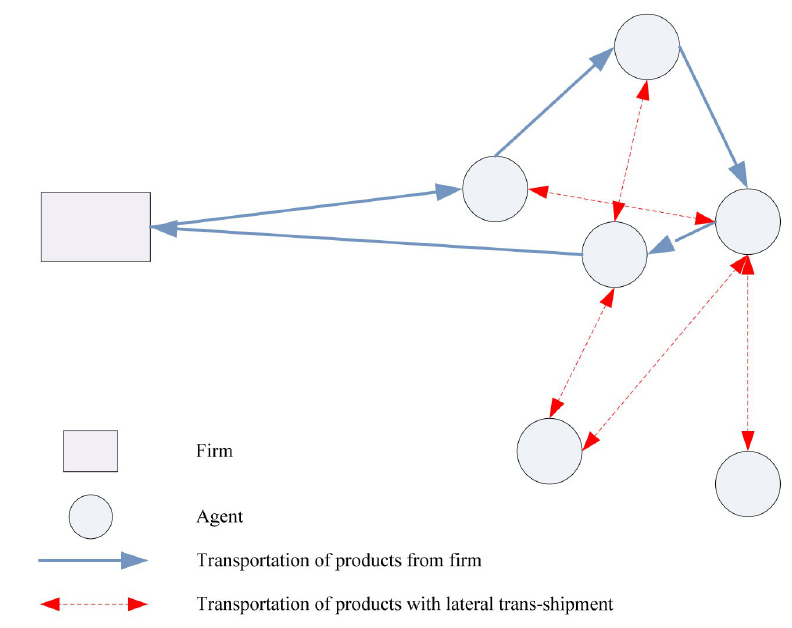
Figure 2. An example of the IRP with lateral